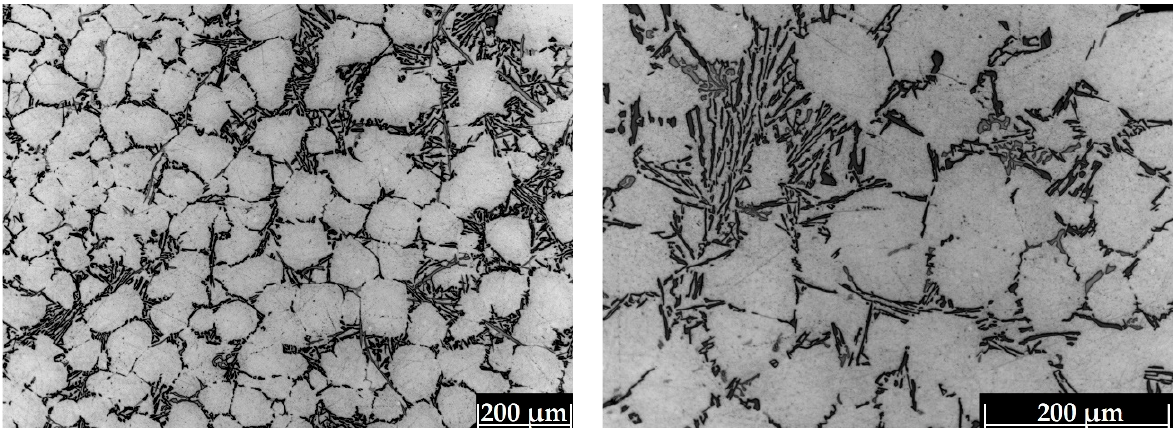
Figure 5. Optical microphotographs of the A356 alloy to different